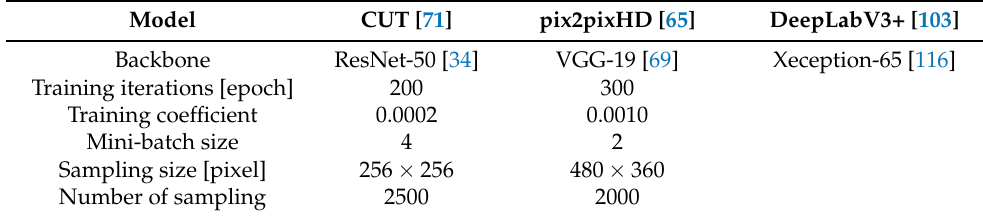
Table 3. Hyperparameters and setting